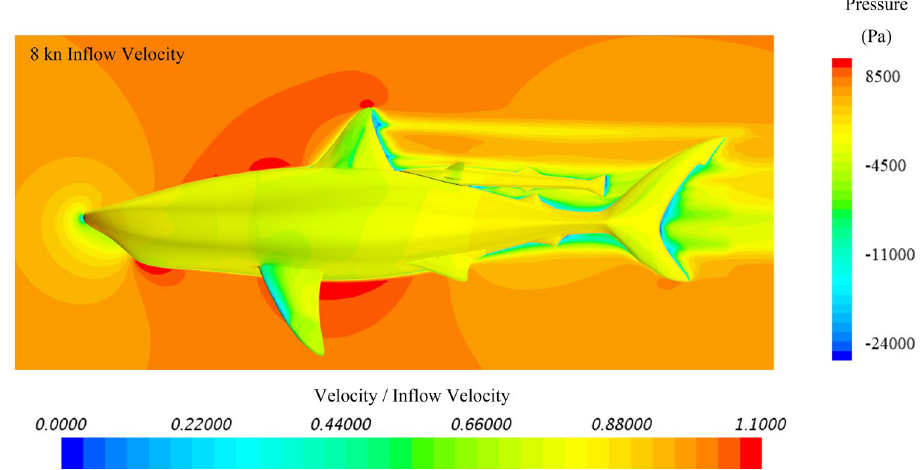
Figure 24. Velocity and pressure contours of the remora attached to the back of the shark (Pressure contour displayed on the surface of model, and velocity contours displayed on the section plane) (Created using Simcenter STAR-CCM + 2019.2.1 Build 14.04.013).